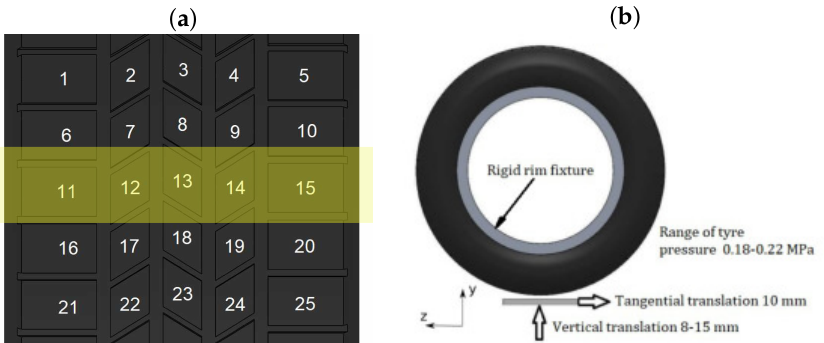
surface were labelled. The tyre tread labelling profile is given in Figure 2a, and the moving directions of the tyre and road interface are given in Figure 2b.